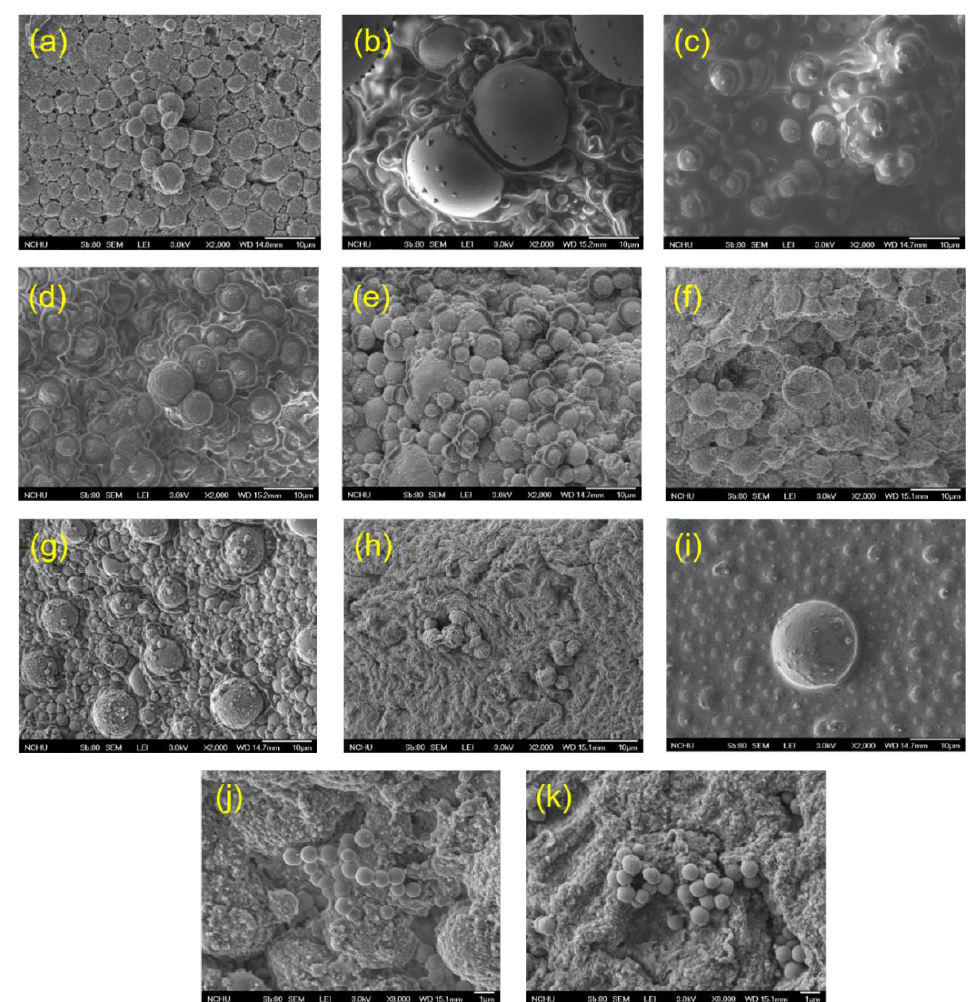
Figure 4. SEM micrographs of mayonnaise. ( a ) Control. ( b ) 61 °C/5 min, ( c ) 61 °C/10 min, ( d ) 64 °C/5 min, ( e ) 64 °C/10 min. ( f ) 67 °C/5 min, ( g ) 67 °C/10 min, ( h ) 70 °C/5 min, ( i ) 70 °C/10 min. Magnification 2000×. ( j ) 67 °C/5 min, ( k ) 70 °C/10 min (at 8000×).